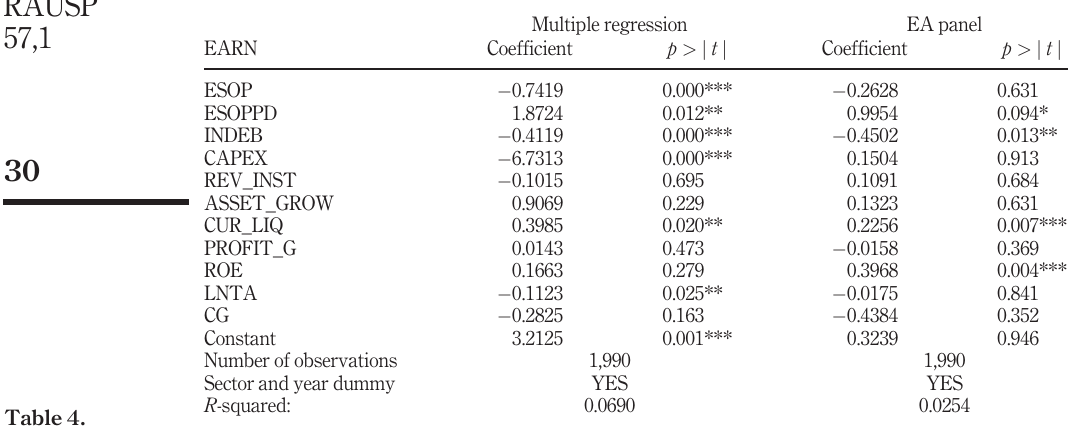
Table 4. Multiple regression and